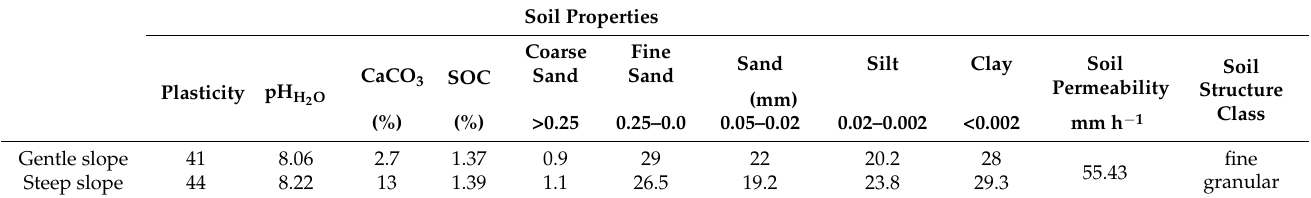
Table 1. Soil properties of the examined soils in the 0–30 cm